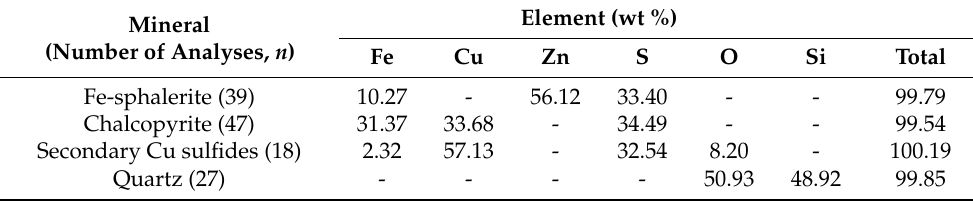
Table 2. Average chemical composition of sulfides from st. 242.